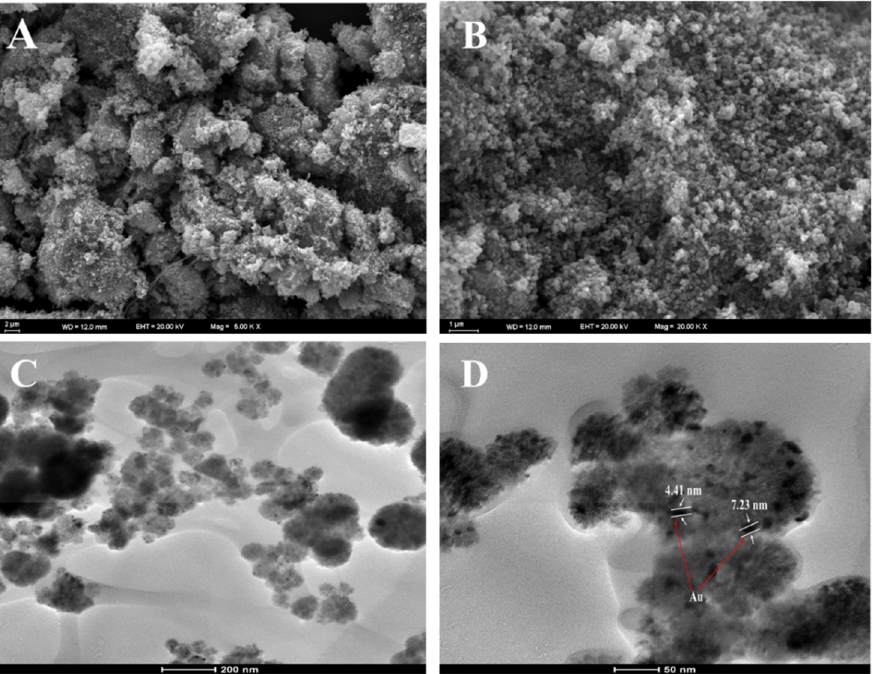
Figure 2. ( A ); SEM image of NiFe 2 O 4 , ( B ); SEM image of Au@NiFe 2 O 4 , ( C , D ); TEM image of Au nanoparticles deposited on the NiFe 2 O 4 .